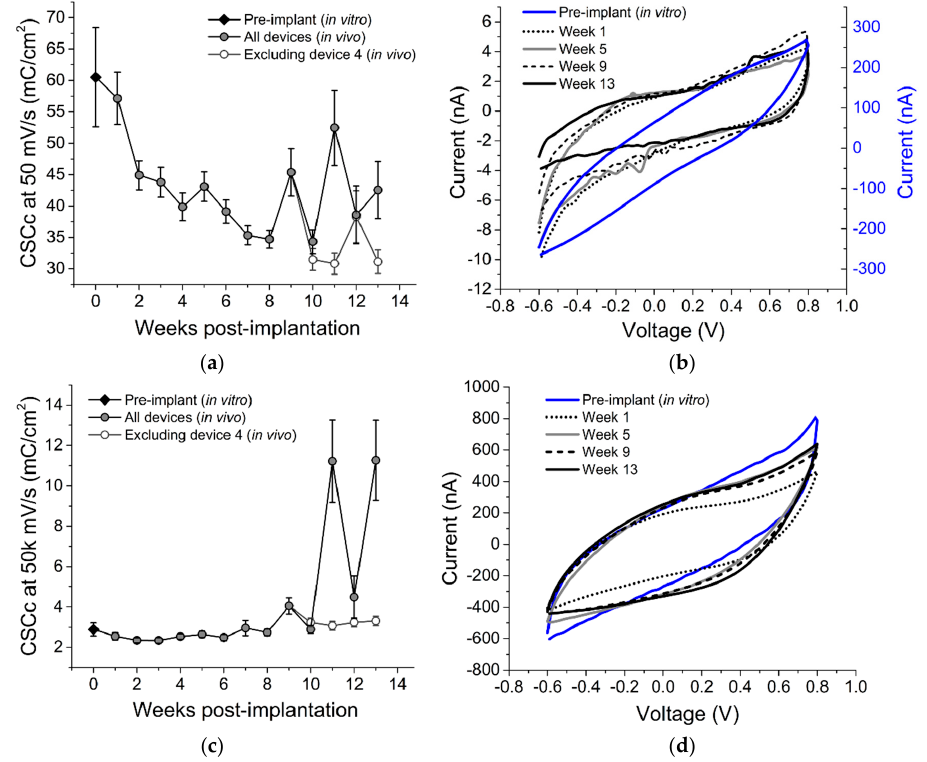
Figure 5. Cyclic voltammetry (CV) results. ( a , c ) slow (50 mV/s) and fast (50 k mV/s) CV over 13 weeks, ( b , d ) slow and fast CV curves across five time points on a representative